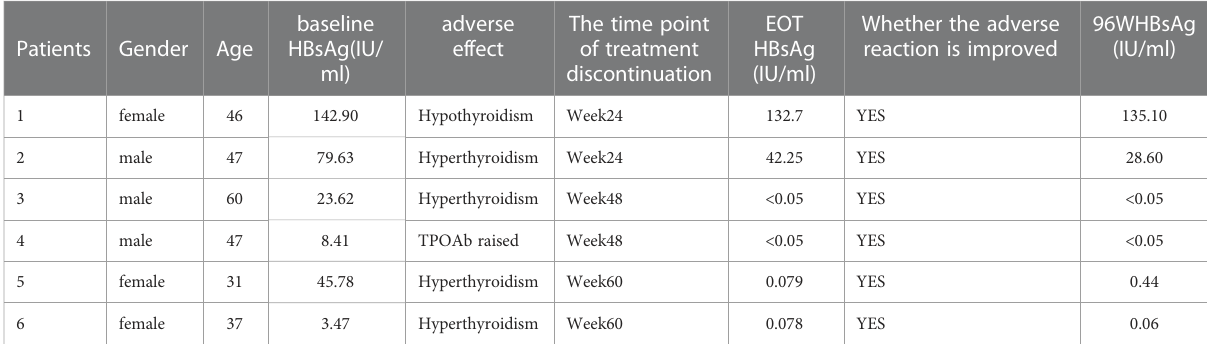
TABLE 5 Adverse effect of the study population.